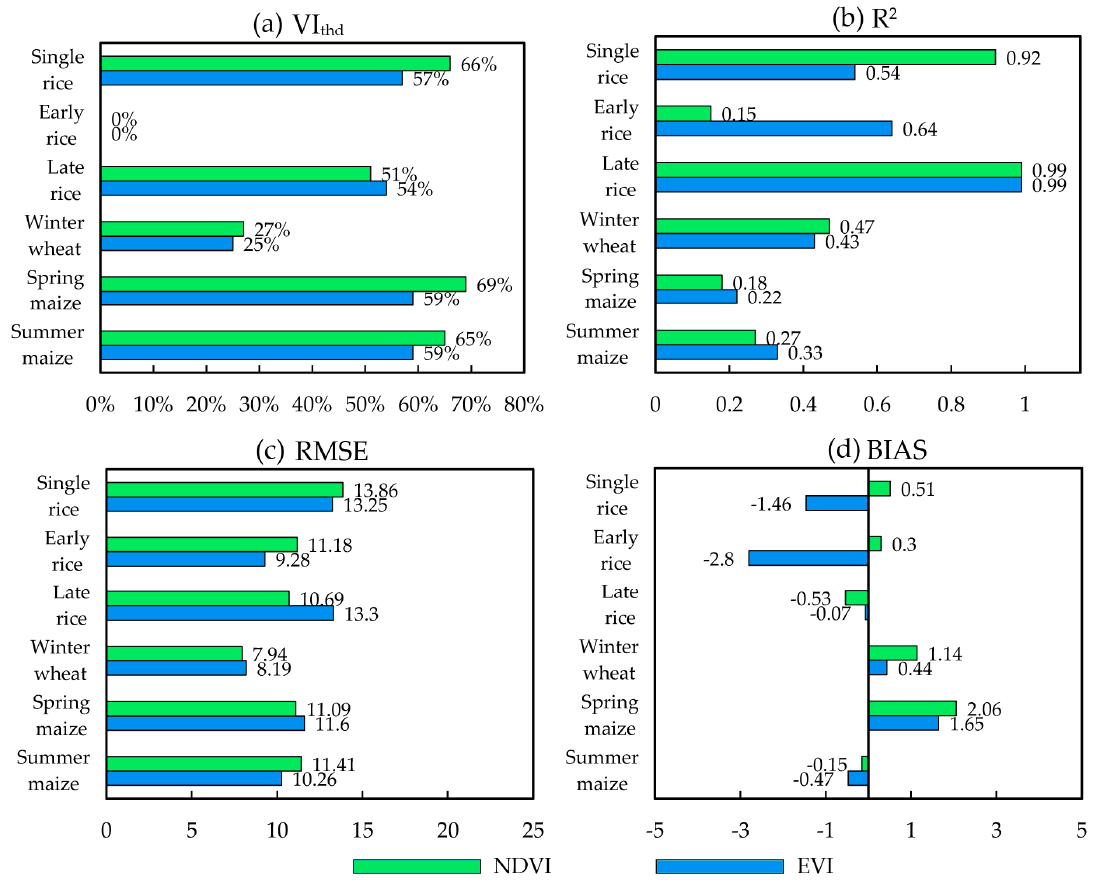
Figure 8. The optimal thresholds and the corresponding accuracies of the retrieved the end of the season (EOS) based on Normalized Difference Vegetation Index (NDVI) (green) and Enhanced Vegetation Index (EVI) (blue). ( a ) The optimal threshold (VI thd ), ( b ) Coefficient of determination (R 2 ), ( c ) Root Mean Square Error (RMSE), ( d ) BIAS.